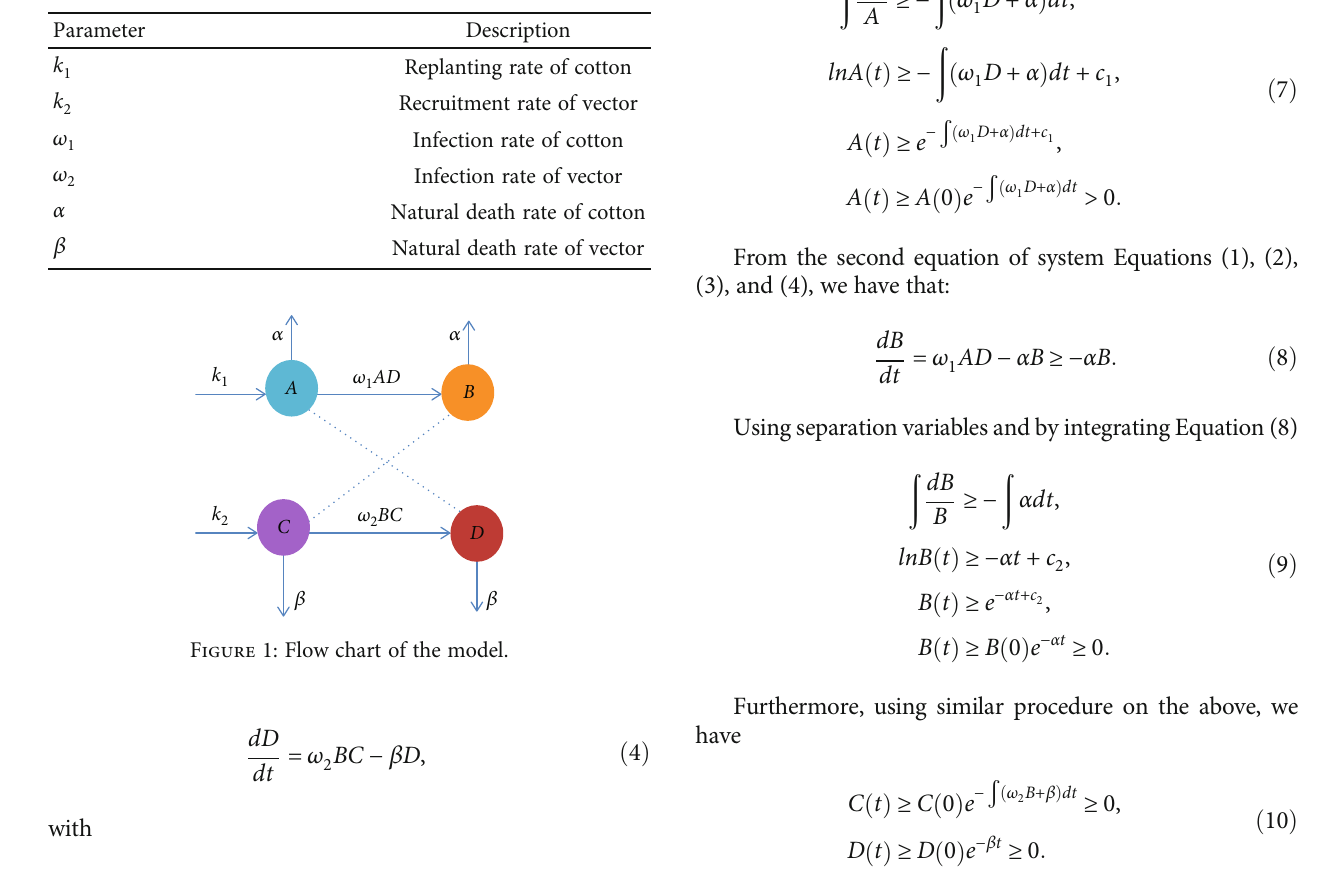
Table 1: Parameters of the model.